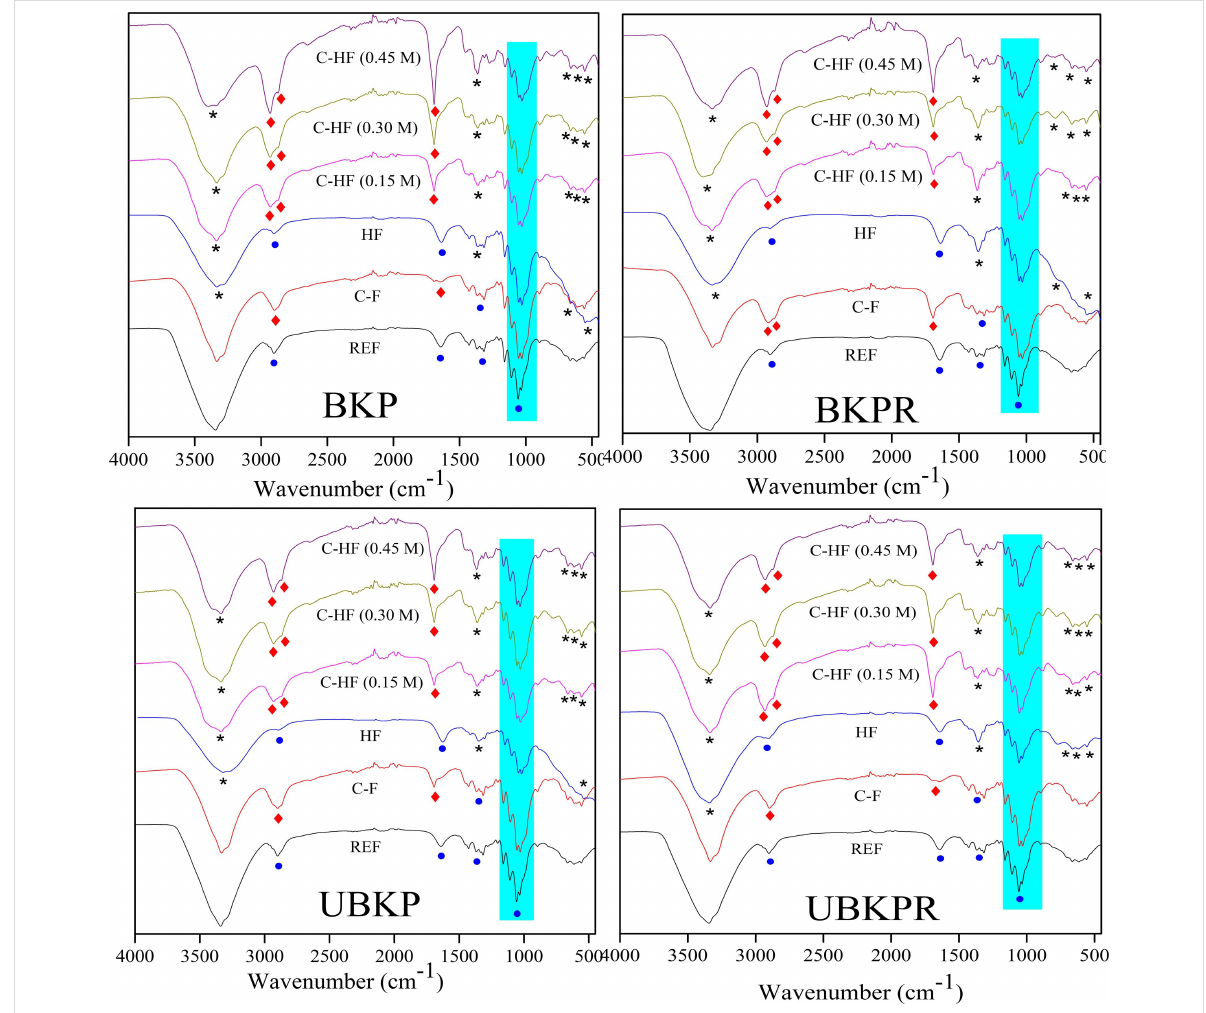
Figure 3: FTIR spectra of pulp fibers (filled circles: fibers, asterisks: LDH, filled diamonds: abietic acid).